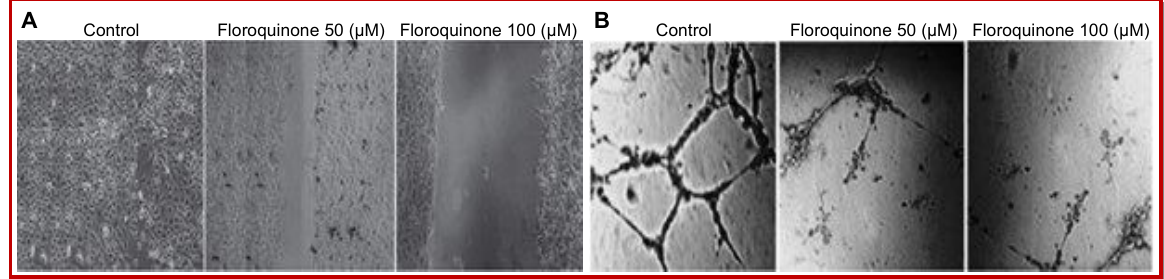
Figure 4: Floroquinone treatment of HUVECs cells inhibits angiogenesis. (A) The cells in matrigel were treated with floroquinone and then analyzed for tube formation potential. (B) The cells treated with floroquinone were analyzed for migration potential